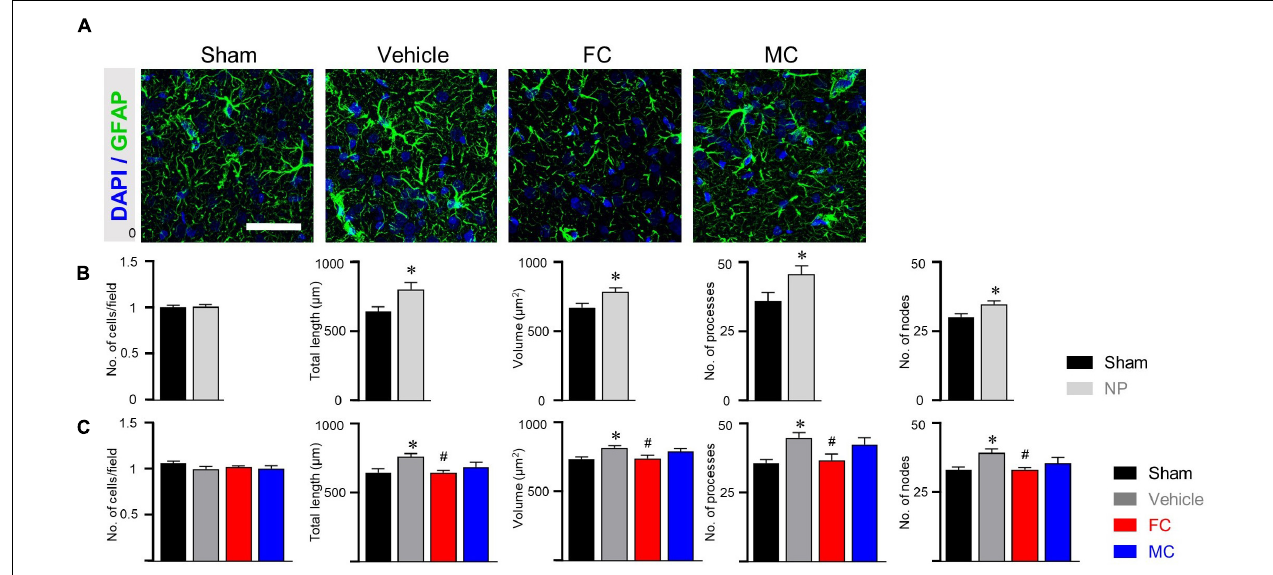
FIGURE 5 | Morphological alterations in astrocytes after late inhibition. (A) Representative images of GFAP-positive astrocytes in the IC on PID 14. Increased complexity of astrocytes was observed in the vehicle group compared to the sham group. The FC- and MC-injected groups showed decreased morphological properties compared to the vehicle group. Scale bar, 50 µ m. (B) Nerve injury increased the morphological complexity of astrocytes on POD 7 (sham and NP; each group n = 4). (C) Morphological complexity of astrocytes on PID 14. Total length, volume, number of processes, and number of nodes were quantified by the Sholl analysis protocol (sham, vehicle, FC, and MC; each group n = 4). Error bars are SEM; ∗ p < 0.05 vs. sham; # p < 0.05 vs. vehicle; one-way ANOVA followed by Tukey’s post hoc multiple comparison